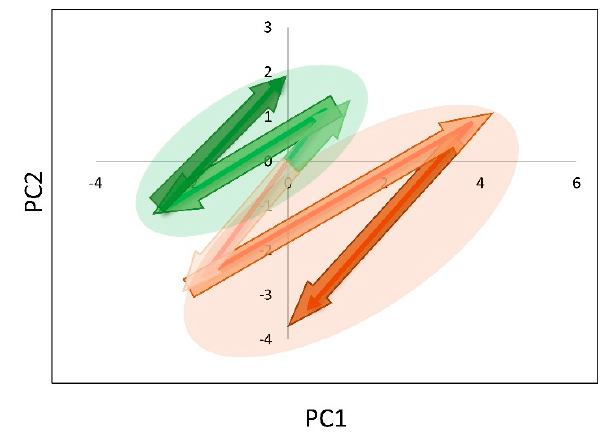
Figure 9. Lipoproteins profile trajectories during the two-year follow-up from T4 to T7 of relapsed and disease-free ER-positive patients. Trajectories were evaluated by using the first two components score from PCA analysis performed at each time point and normalized to T4 value. Trajectories of relapsed ( n = 8) and disease-free ( n = 10) patients are coloured in red and green,